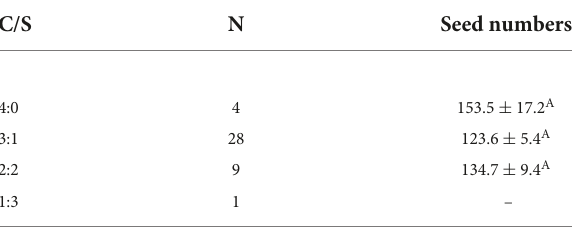
TABLE 4 Results of Tukey–Kramer honest significant difference test for the effect of treatment with different ratios of cross- and self-pollen on seed numbers per mature fruit in the pollen-enough group.